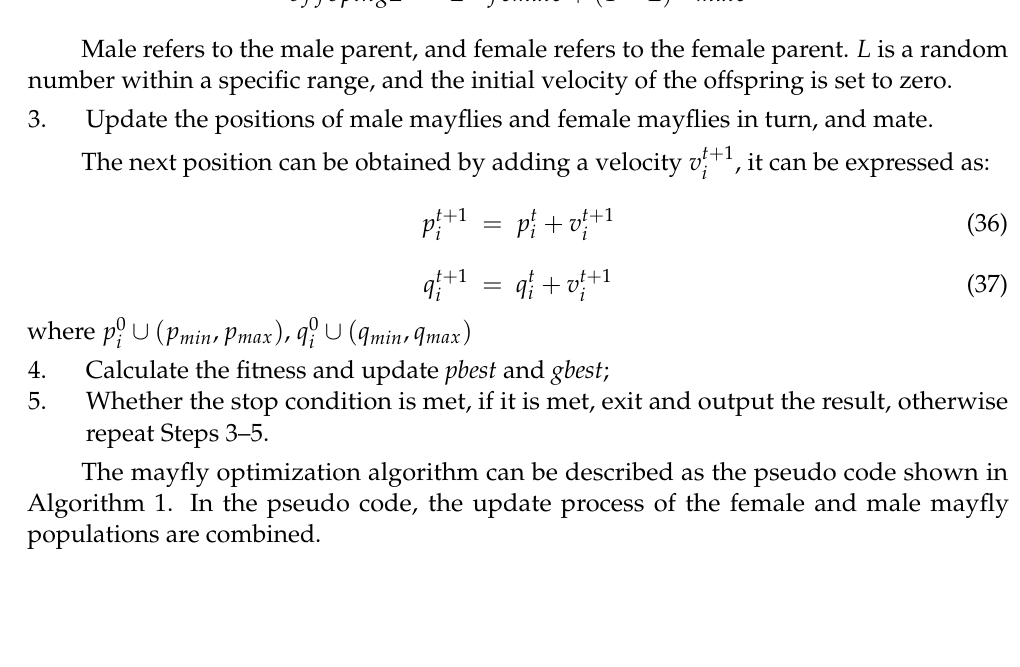
populations are